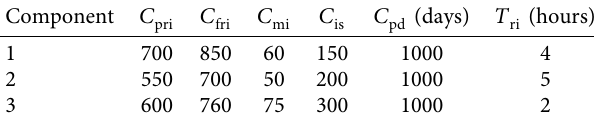
Table 2: Maintenance cost parameters.